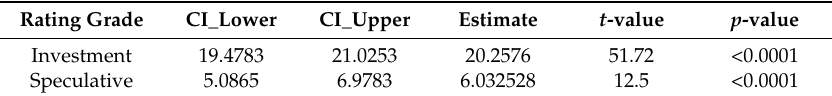
Table 9. Skewness of AER across all trades in